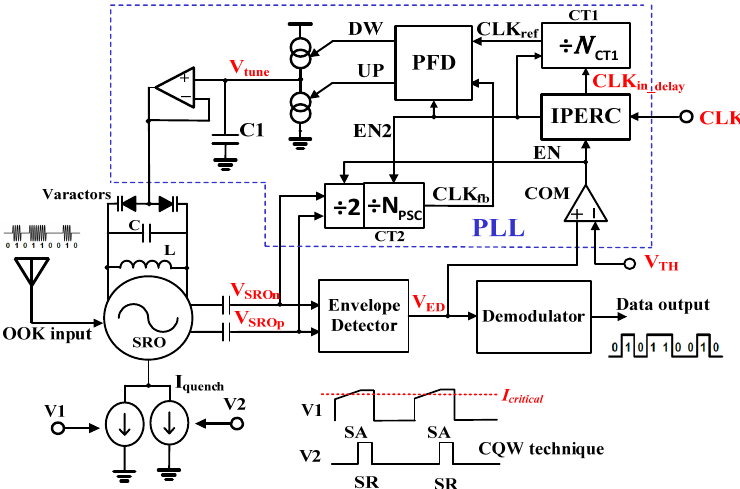
Figure 7. The block diagram of the proposed SR receiver with background frequency calibration and CQW technique.